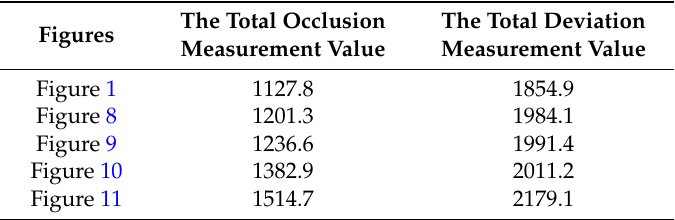
Table 2. The occlusion and deviation measurements values for the scenes shown in the